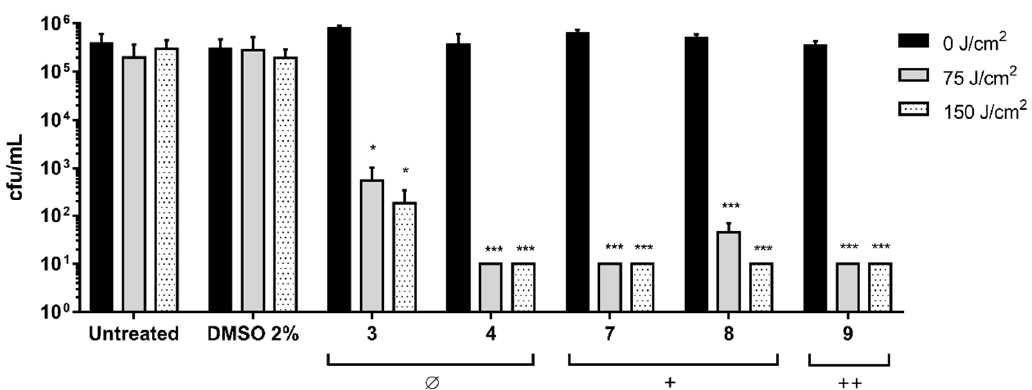
Figure 5. Photodynamic treatment of Candida albicans cells with Porphyrins 3 , 4 , 7 – 9 . The neutral (Ø), monocationic ( + ), and dicationic ( ++ ) porphyrins were administered at a concentration of 10 µM and activated by blue light irradiation at 75 and 150 J/cm 2 . Control samples in the dark are also presented (black bars). Untreated and solvent-treated samples (2% DMSO) were also included. Values, presented as cfu / mL, are the mean of at least three independent experiments, and the bars represent standard deviations. Statistical analyses were performed by one way ANOVA (* p < 0.05; *** p < 0.0001).